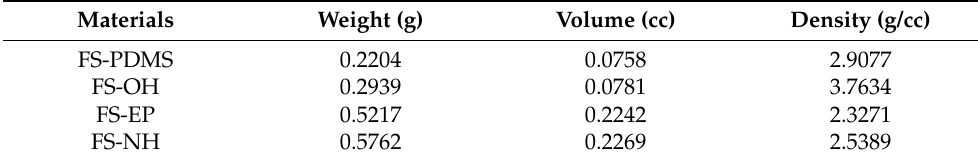
Table 1. Density of silica nanoparticles.